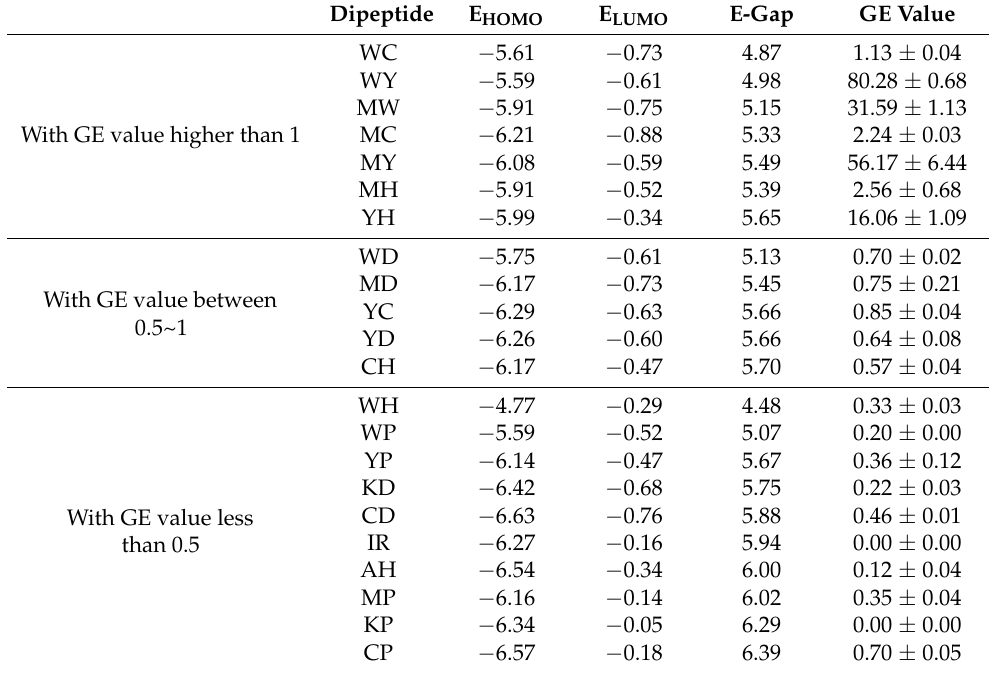
Table 3. Frontier molecular orbital energy(eV) and GE (mM/mM) values of the dipeptides against the oxidation of linoleic